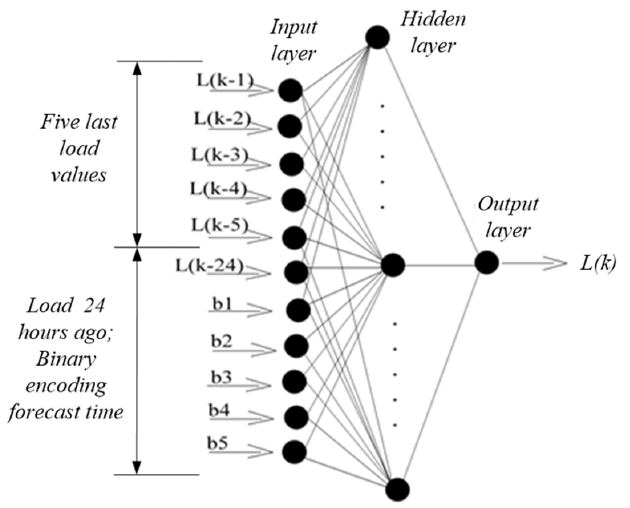
Figure 1. ANN model used in